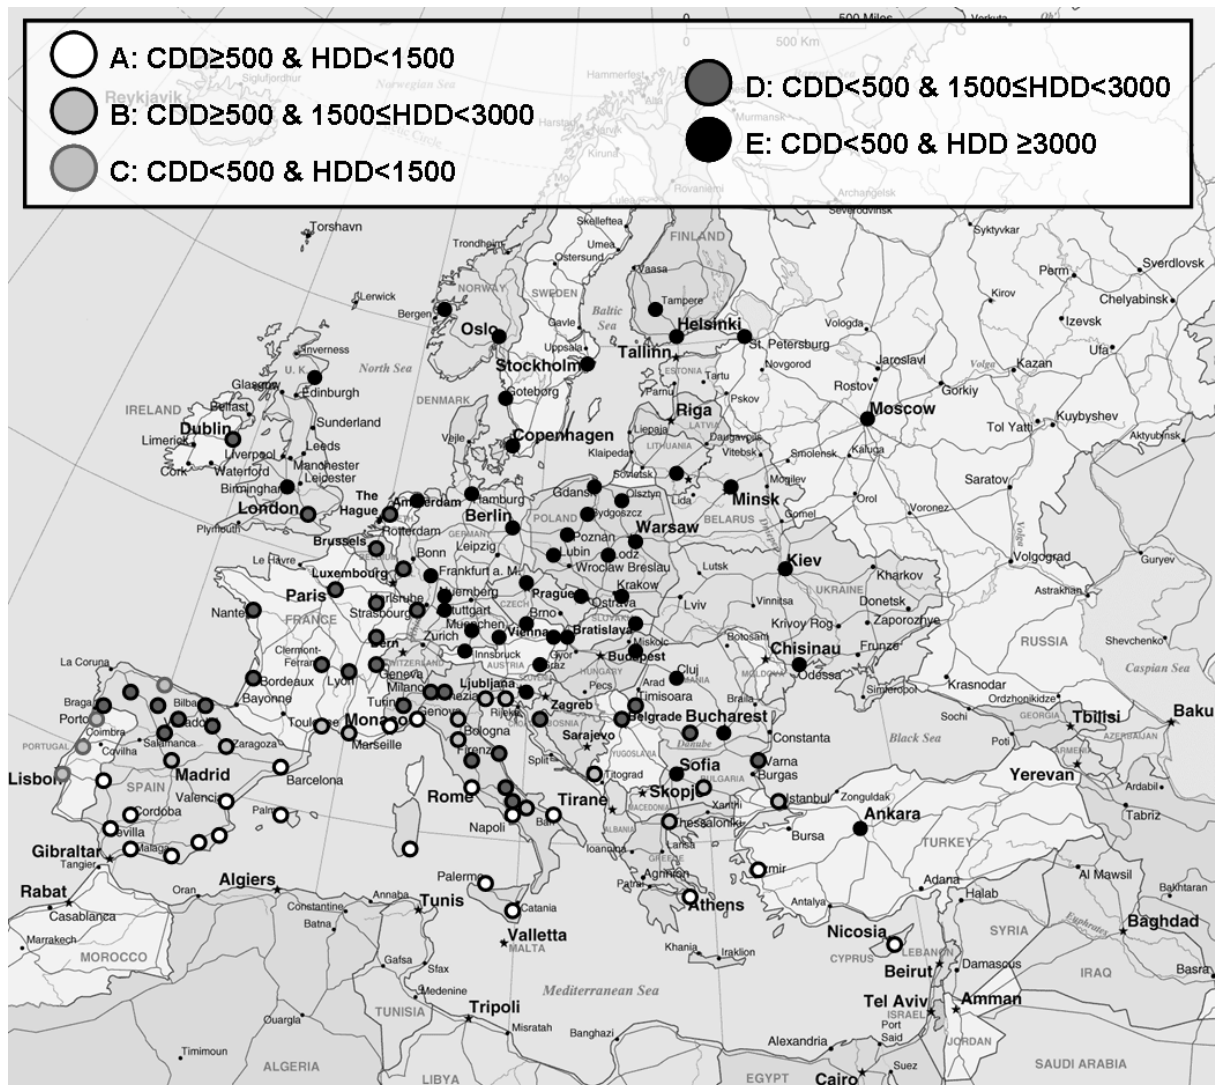
Figure 4. The geographical distribution of selected cities and their classification into climatic zones on the basis of CDD and HDD approach. Map: European